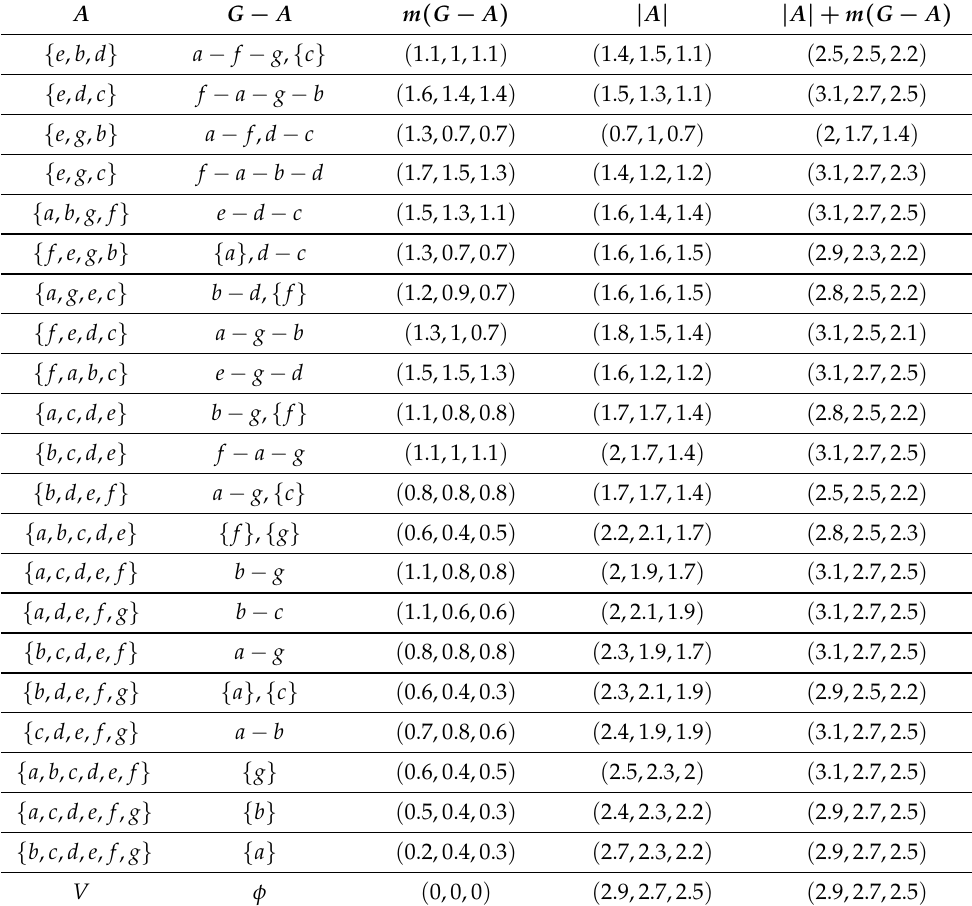
Table 2. Model 3PF domination integrity graph G